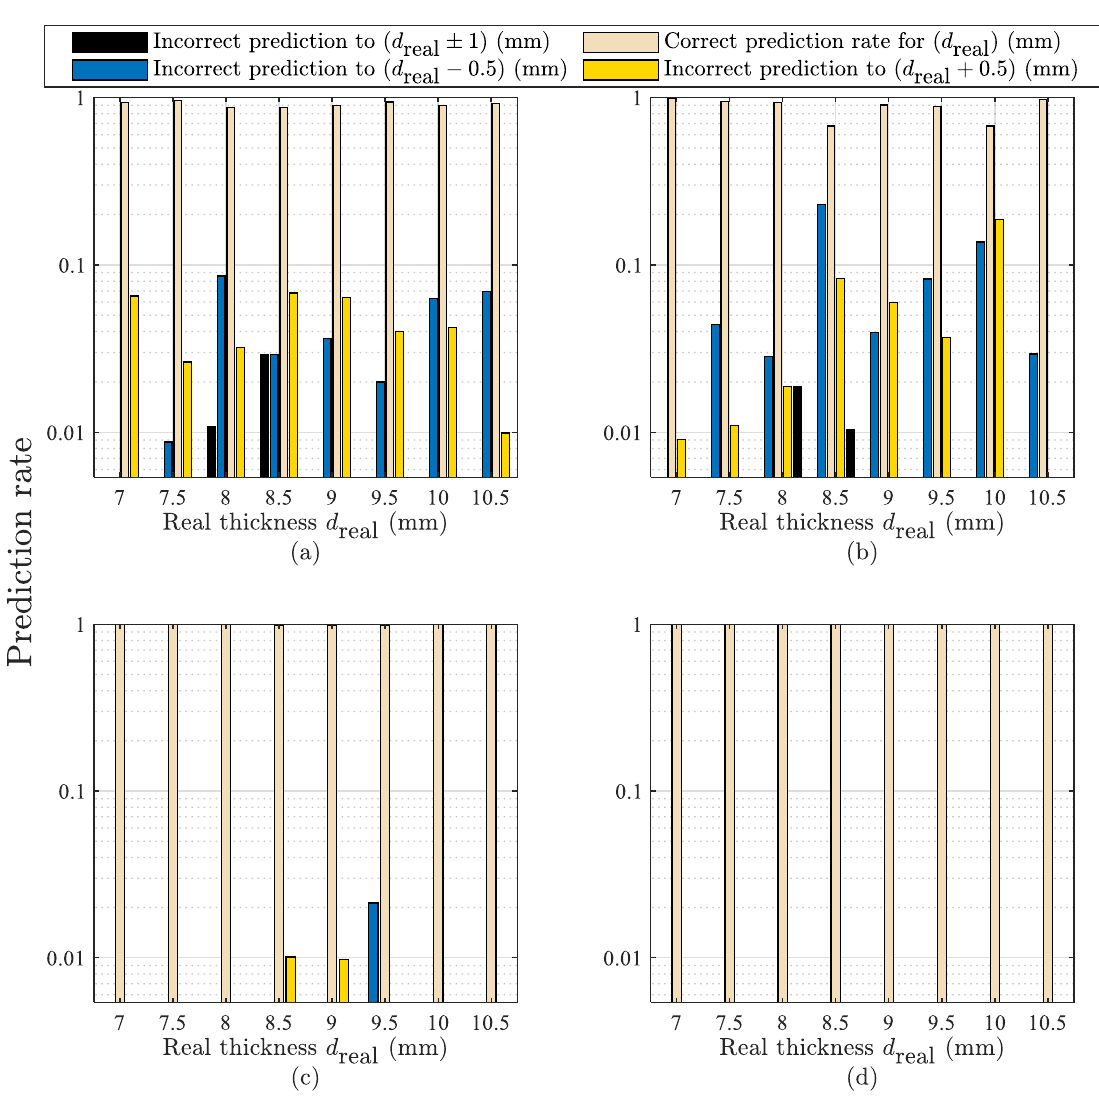
Figure 9. The classification testing results of ( a ) SVM with 20% dataset ( b ) DNN with 20% dataset ( c ) SVM with 70% dataset and ( d ) DNN with 70% dataset.